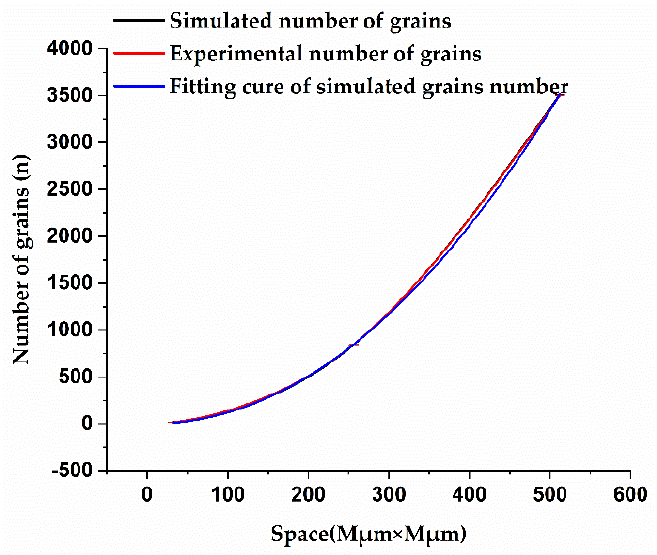
Figure 7. Effect of reaction space on number of active grains. The fitted model for the growth of active abrasive number and reaction space is y = ( 0.00962 ± 0.00015 ) x ( 2.0531 ± 0.00250 ) . The ratio of the regression sum of squares to residual sum of squares R 2 = 0.99999 and the residual sum of squares RSS = 88.3308, suggesting that the curve fit well for predicting the number of active abrasive particles involved in the honing process in different reaction